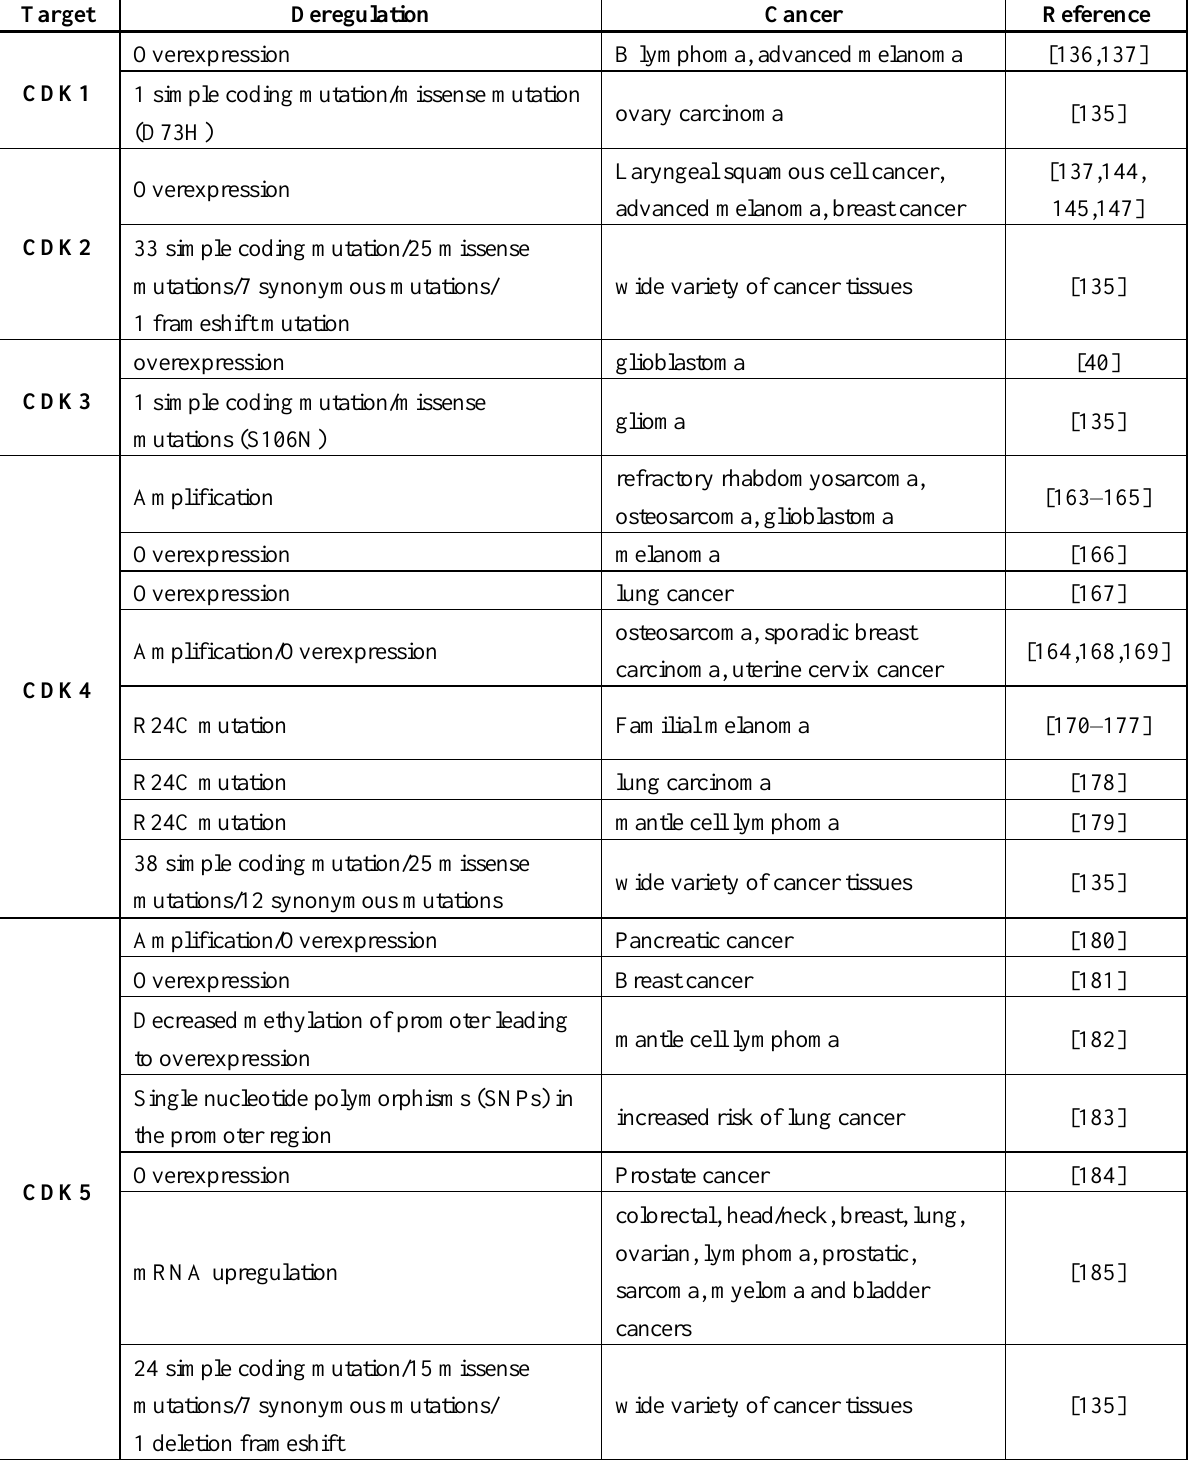
Table 2. CDK and cyclin aberrations associated with